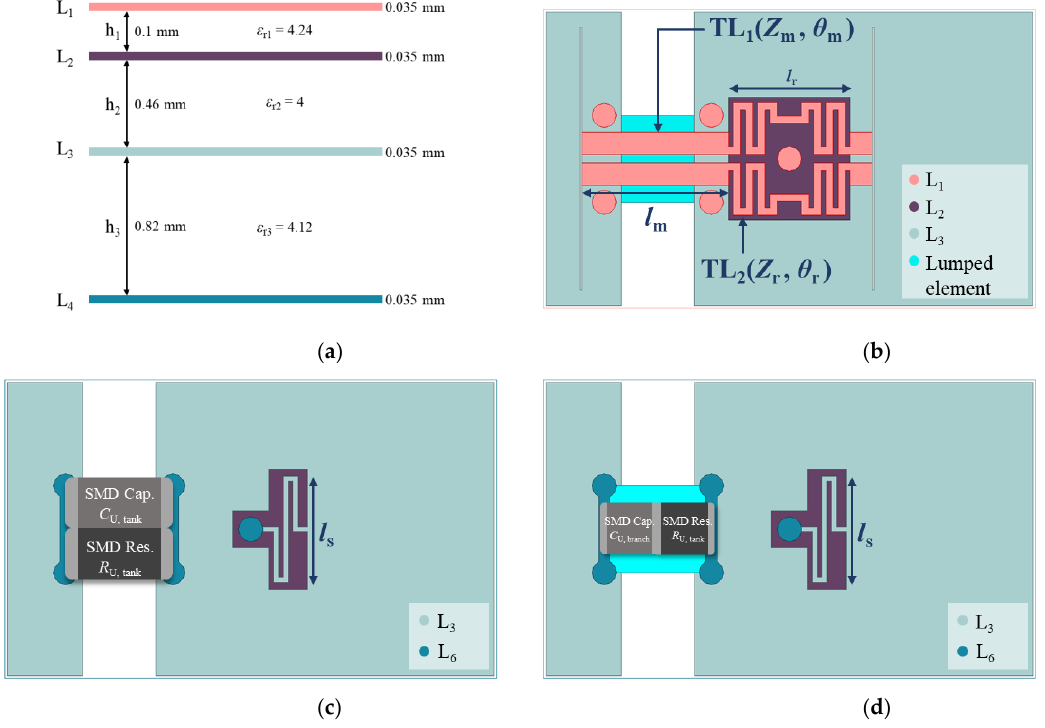
Figure 6. ( a ) The stack of PCB board; ( b ) Top view of the proposed design; ( c ) Bottom view of the proposed design of an RC-tank Unified Circuit; ( d ) Bottom view of the proposed design of an RC-branch Unified Circuit. Table 1. Characteristic Impedance of Practical Structure.